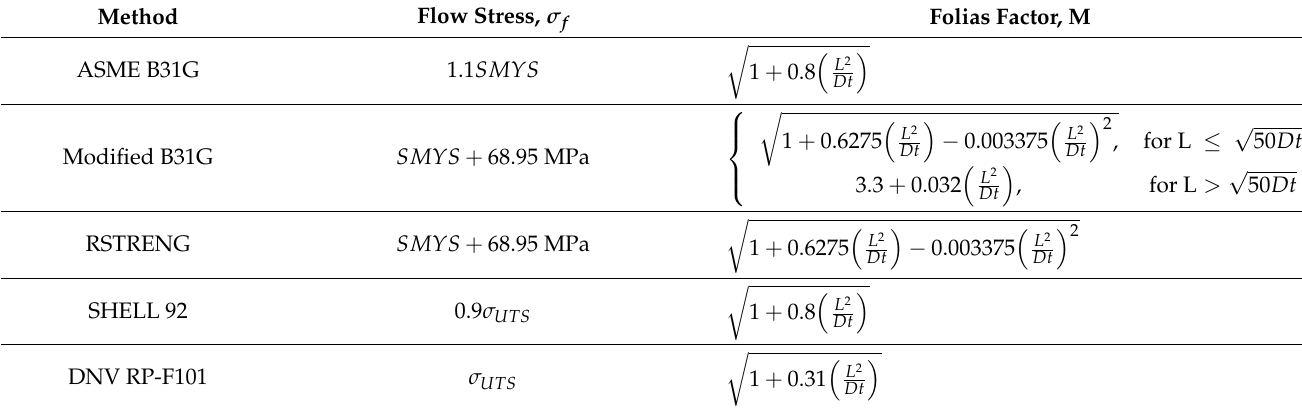
Table 3. Flow stress and Folias factor determination for NG-18-based assessment methods